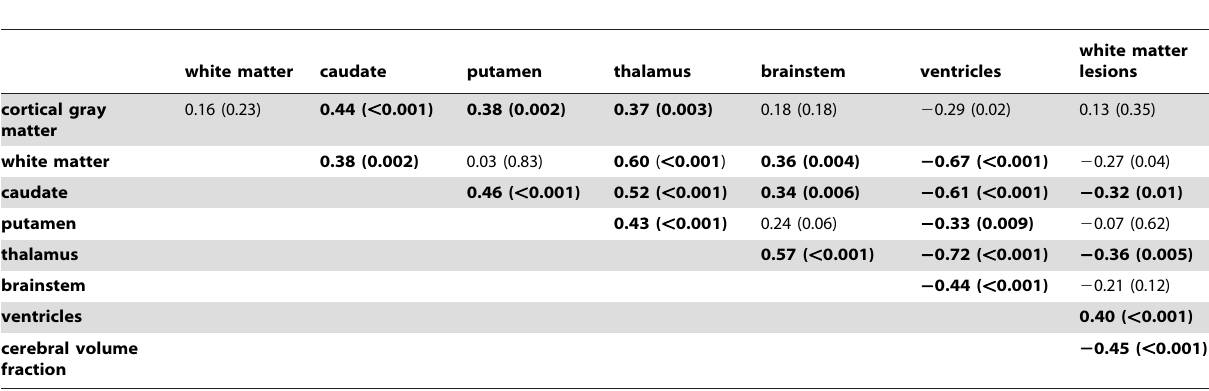
Table 2. Partial correlations of normalized brain structure with one another in MS